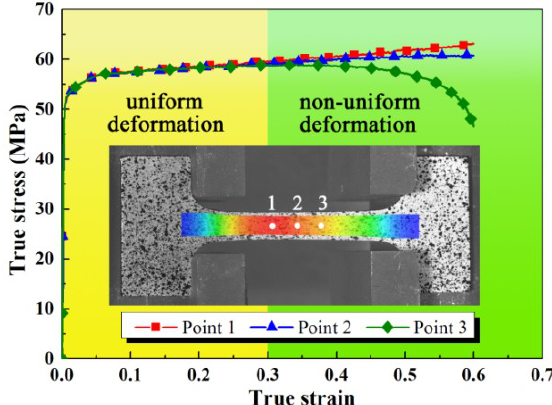
Figure 5. Local stress-strain curves for different local points.